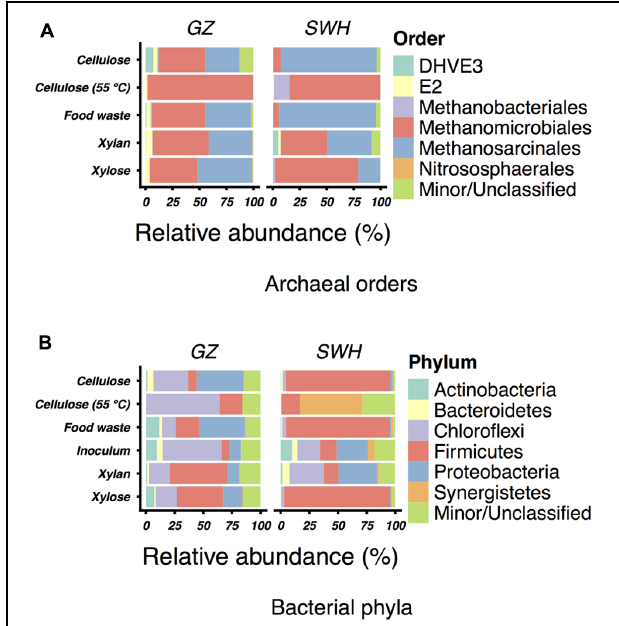
FIGURE 1 | Relative abundances of (A) archaeal orders in the enrichment cultures and (B) bacterial phyla in the cultures and sludge inocula. For each, the six most abundant taxa (excluding unclassified OTUs) by mean relative abundance across all samples are shown. All less abundant and unclassified taxa are grouped in “Minor/Unclassified.” Abundances are for the complete (non-normalized) read set for each sample. Note that the Greengenes taxonomy includes some candidate and uncultured